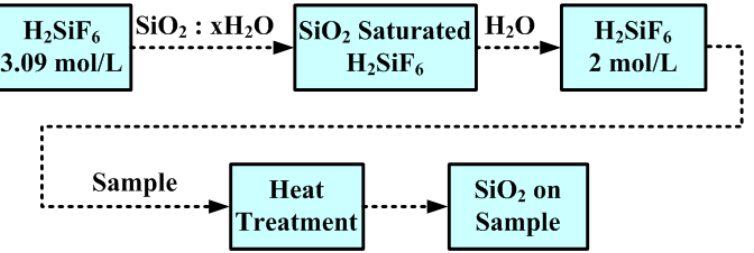
Figure 15. The process flow of liquid phase deposition. The process can be operated at the temperature below 100 ºC, and a thin (~2 nm) SiO substrate